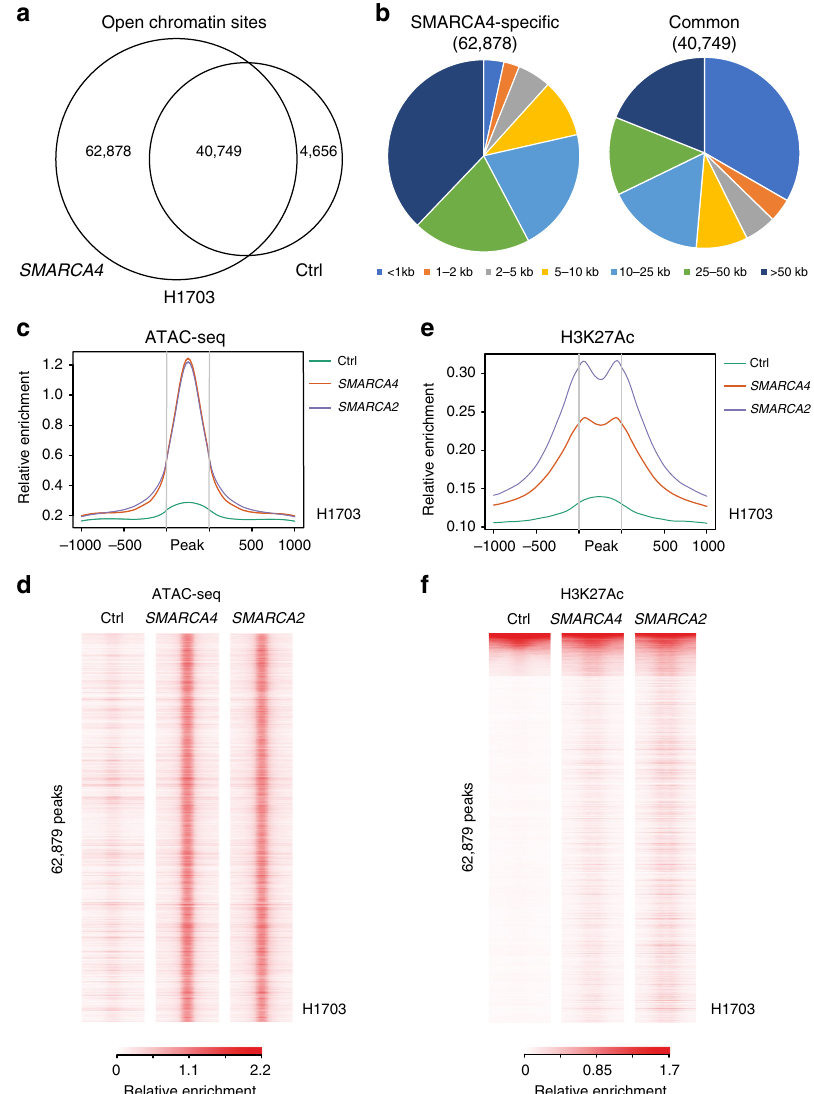
Fig. 4 Extensive opening of regulatory elements by induction of SMARCA4/2. a Venn diagram showing overlap of open chromatin sites in control infected H1703 cells with or without SMARCA4 overexpression. Note the dramatic increase in open chromatin sites upon SMARCA4 overexpression. b Distribution of SMARCA4-dependent and -independent open chromatin sites relative to nearest gene transcriptional start site. Note that SMARCA4-dependent sites are much less likely to be promoters (within 1 kb of transcription start site (TSS)). c , d Metaplot ( c ) and heatmap ( d ) of assay for transposase-accessible chromatin sequencing (ATAC-seq) read data from control-infected, SMARCA4-infected and SMARCA2-infected cells over the 62,878 SMARCA4- dependent ATAC peaks. Note similar effect of SMARCA2 and SMARCA4. e , f Metaplot ( e ) and heatmap ( f ) of H3K27Ac chromatin